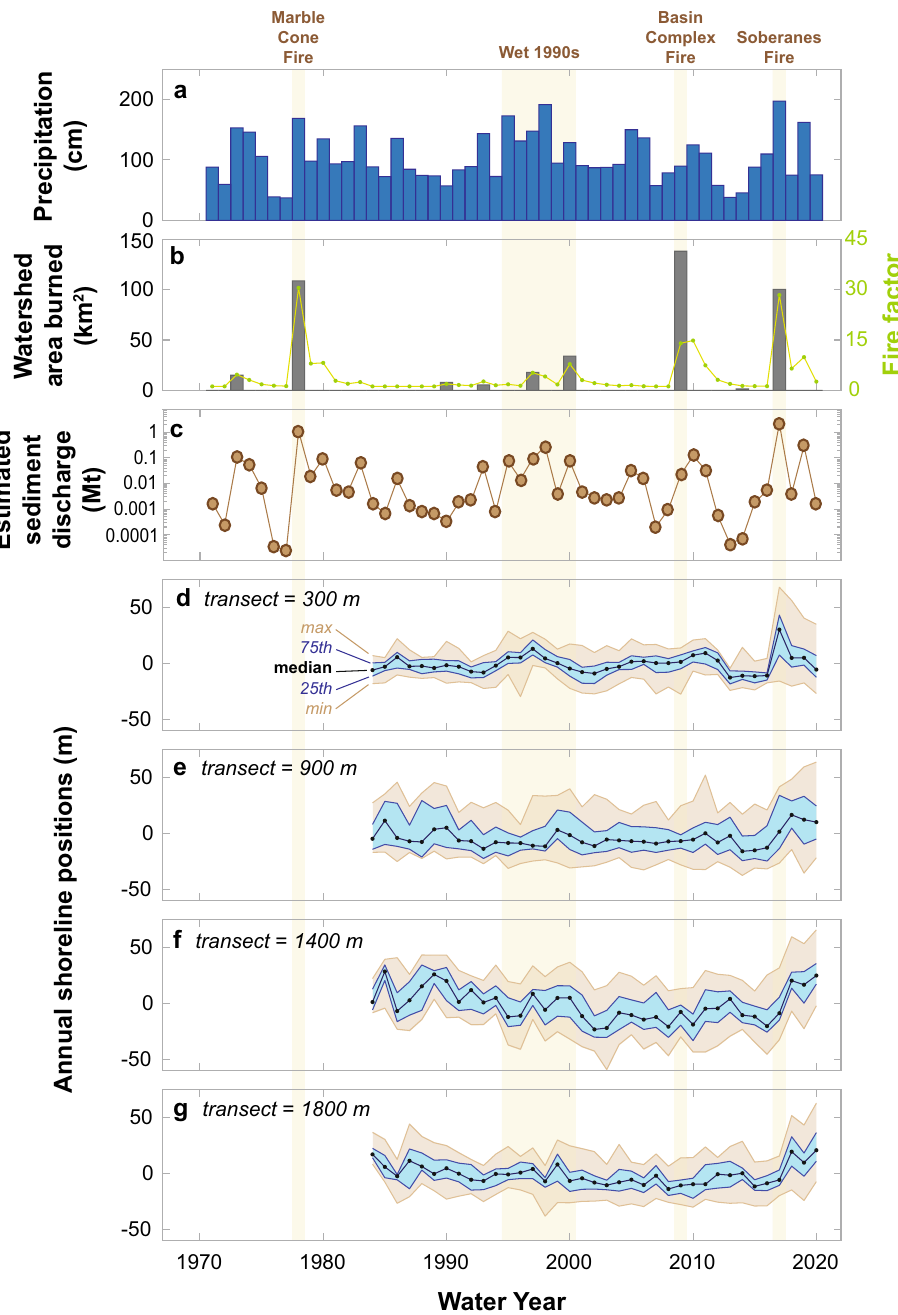
Figure 2. Annual observations of the Big Sur River mouth study area summarized over water year increments of time (Oct 1–Sept 30). ( a ) Annual precipitation at the Big Sur State Park (BGS) sensor. ( b ) Annual area of the Big Sur River watershed burned by wildfire (grey bars) and the resulting Fire Factor that defines the magnitude of sediment discharge increase from the combined effects of fire and precipitation (green symbols). ( c ) Estimated annual suspended–sediment discharge from the Big Sur River, symbol size is proportional to the 1-σ lognormal variance of each estimate. ( d – g ) Shoreline positions for 4 of the 18 CoastSat transects summarized by annual statistics, including the median, 25th and 75th percentiles, and the minimum and maximum. Shading highlights the interquartile range (blue) and the total range (brown) for each water year. A complete set of annual plots for all transects is provided in the Supplemental